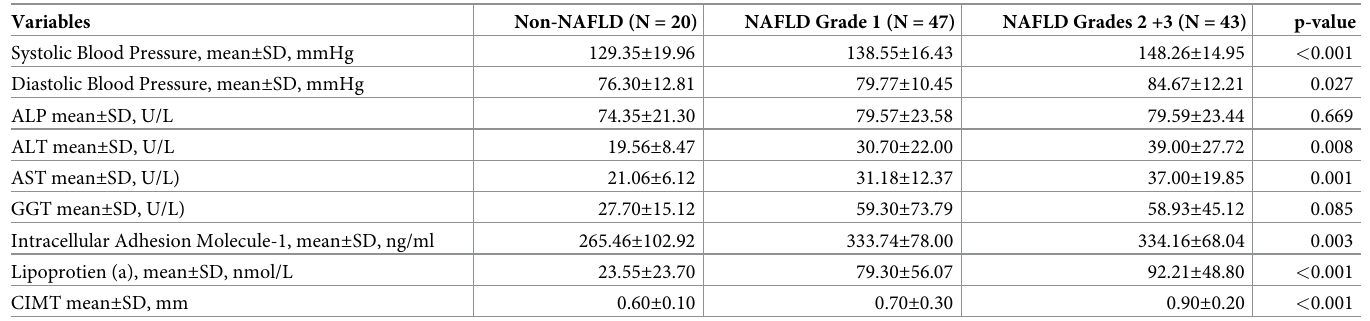
significantly higher proportion of patients with NAFLD 2+ 3 within the severe AHI group compared to the mild AHI group (61.9% vs 14.3%, p < 0.001). There was indeed a significant correlation between the severity of OSA and NAFLD; r = 0.384, p < 0.001. Refer Table 4. Logistic regression analysis was performed to ascertain the effects of blood pressure, BMI, likelihood of OSA patients having NAFLD. Patients with OSA and elevated AHI of > 30 were Patients with OSA were also more likely to have NAFLD with co-existing hypertension (OR addition, elevated surrogate markers of ICAM-1 and Lp(a) level were more likely to be present in patients with NAFLD with OR 14.53 and 27.22, respectively (p = 0.011 and p = 0.001). Refer Table 5 . Multiple logistic regression analysis was performed to adjust for the predictors for NAFLD in OSA patients. The interaction and multicollinearity were also checked within the overall Table 3. Comparison of clinical parameters between different groups of NO NAFLD, NAFLD 1 and NAFLD 2+3.